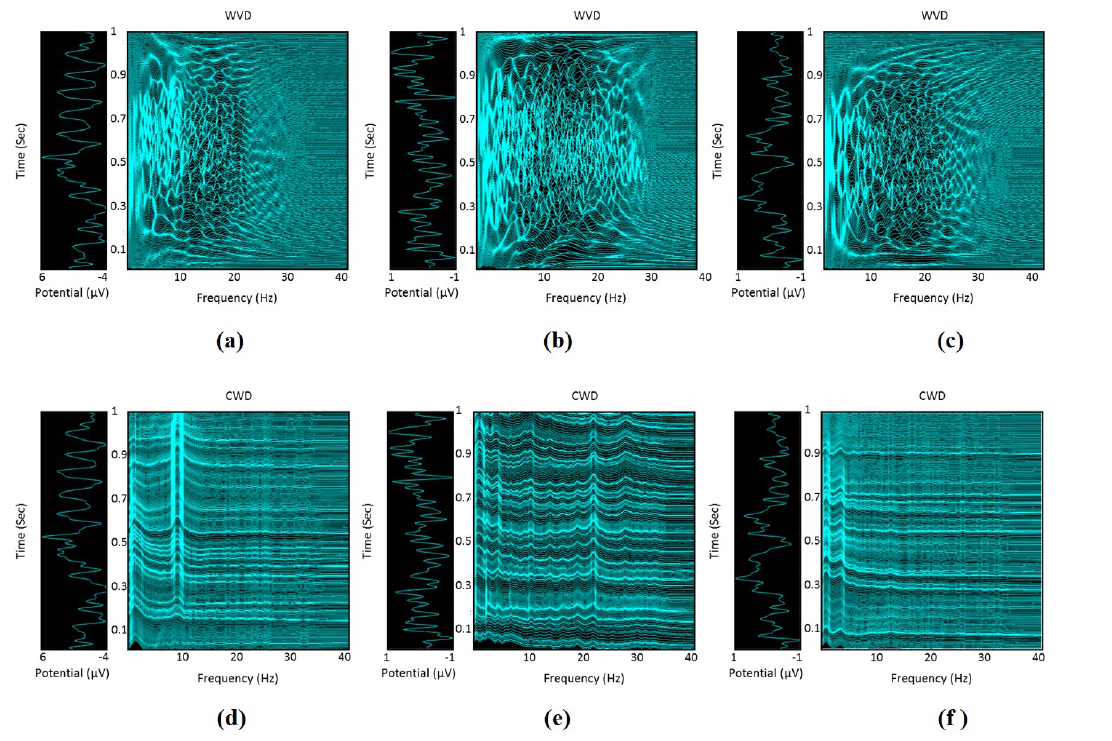
Figure 4. Illustration of the constructed time-frequency representation of EEG segments. The plots ( a – c ) represent the WVD of the EEG segments associated with rest, wrist flexion/extension, and lateral grasp, respectively. The plots ( d – f ) represent the CWD of the EEG segments associated with rest, wrist flexion/extension, and lateral grasp,